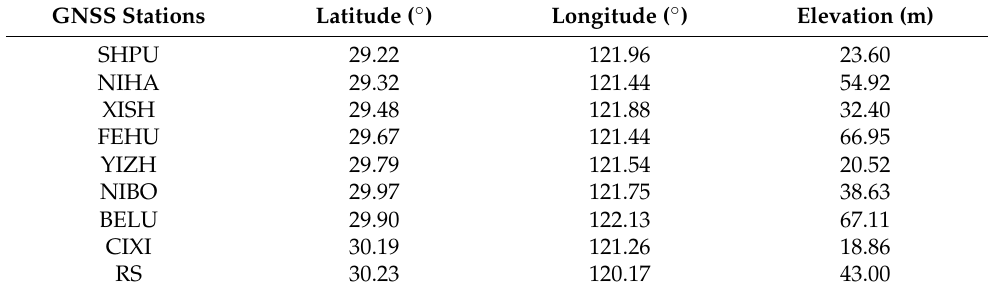
Table 1. The position coordinates information of the 8 GNSS and RS stations in Ningbo, Zhejiang province.